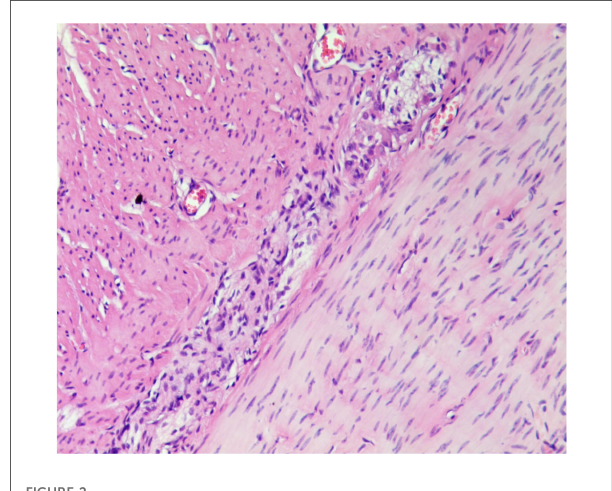
FIGURE 2 Proliferation of nerve fi bers in the myenteric plexus of dilated intestine. A small number of less developed ganglion cells can be seen.